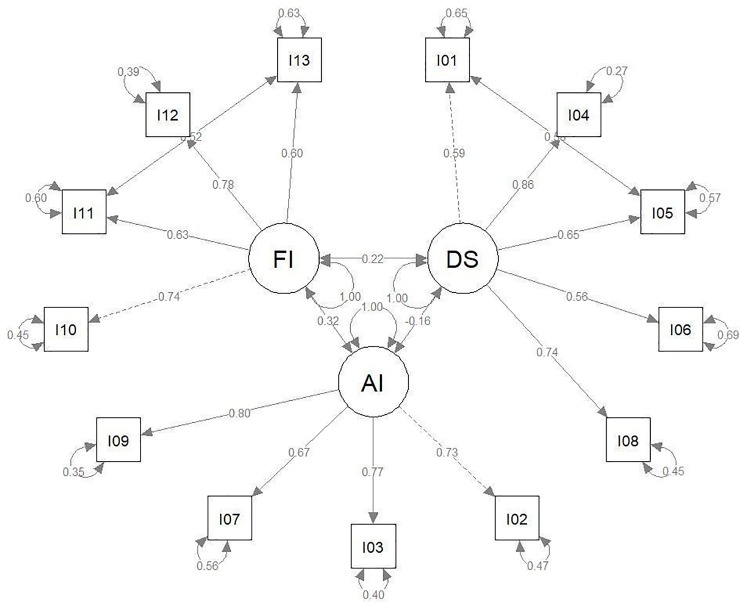
R-Code of MDDI factor model.model.MDDI <—'.+ DS = ~ I01 + I04 + I05 + I06 + I08.+ AI = ~ I02 + I03 + I07 + I09.+ FI = ~ I10 + I11 + I12 + I13.+ DS ~~ AI.+ DS ~~ FI.+ AI ~~ FI.+ I01~~I05.+ I11 ~~ I13'.